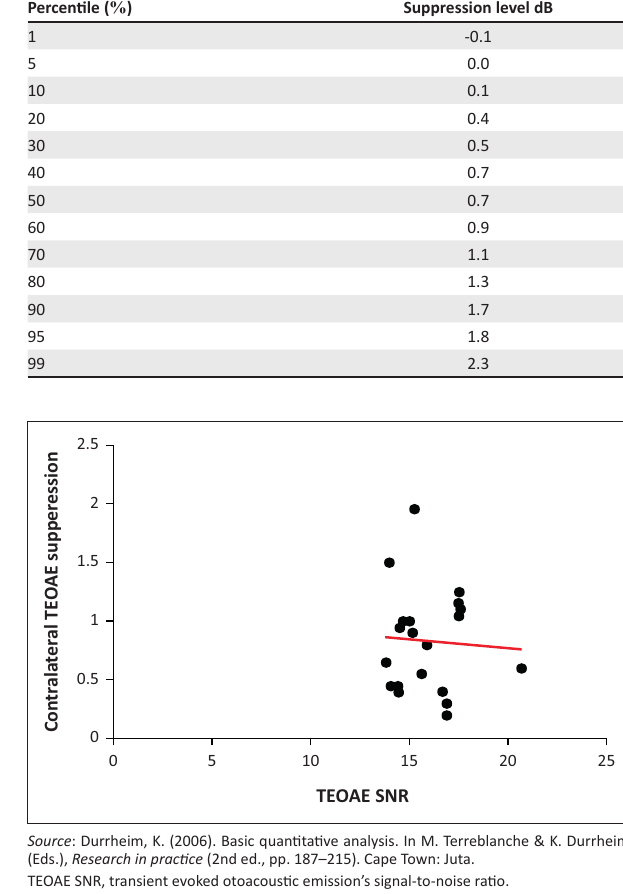
FIGURE 3: Linear regression graph of transient evoked otoacoustic emission’s signal-to-noise ratio and contralateral acoustic stimulation